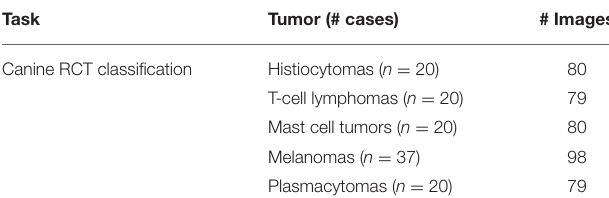
TABLE 1 | Histological classification of 117 cutaneous canine round cell tumors. Task